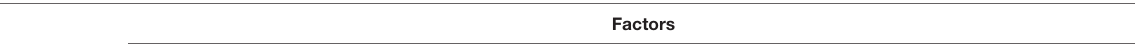
TABLE 4 | Summary of the factor loadings for EMOTICOM tests on factors